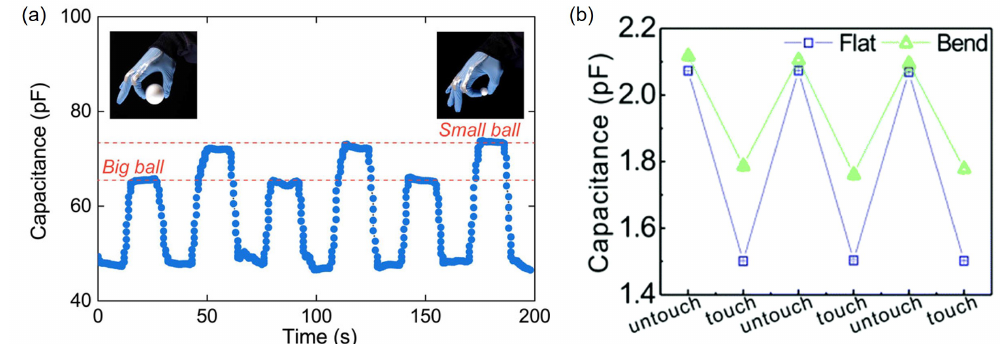
Figure 12. ( a ) Capacitance change of a parallel-plate liquid metal capacitor measured for 200 s. When big and small balls are picked up alternatingly, the capacitor experiences two different bending angles thus shows two constant levels during the repeated test. Reprinted with permission from [78]. Copyright (2019) American Chemical Society. ( b ) Capacitance measurement of a fork-shaped